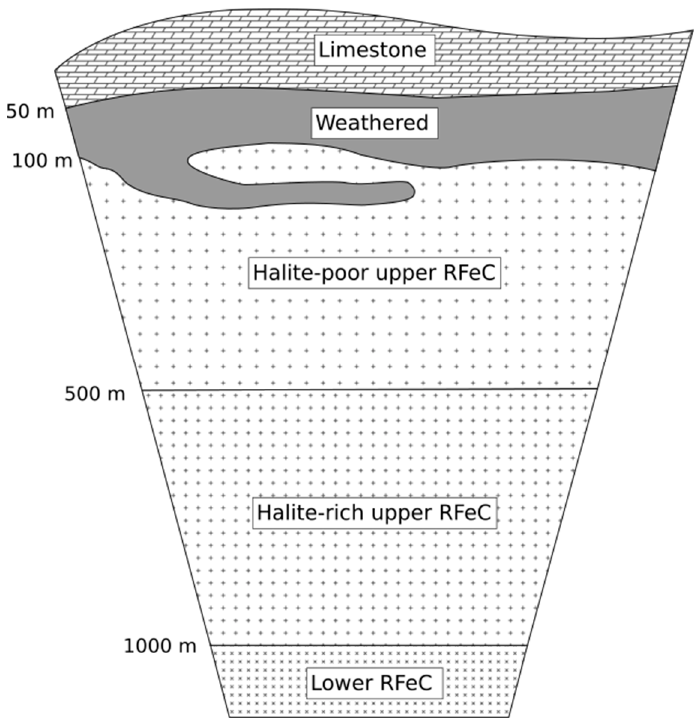
Figure 3. Schematic vertical cross section of the Saint-Honoré REE zone. RFeC = REE-rich Fe-carbonatite.